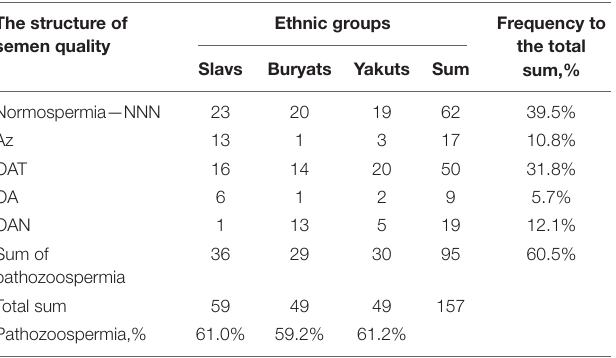
TABLE 1 | emen and ethnic characteristics of men in the preselected sample prepared for the whole exome sequencing. The structure of semen quality